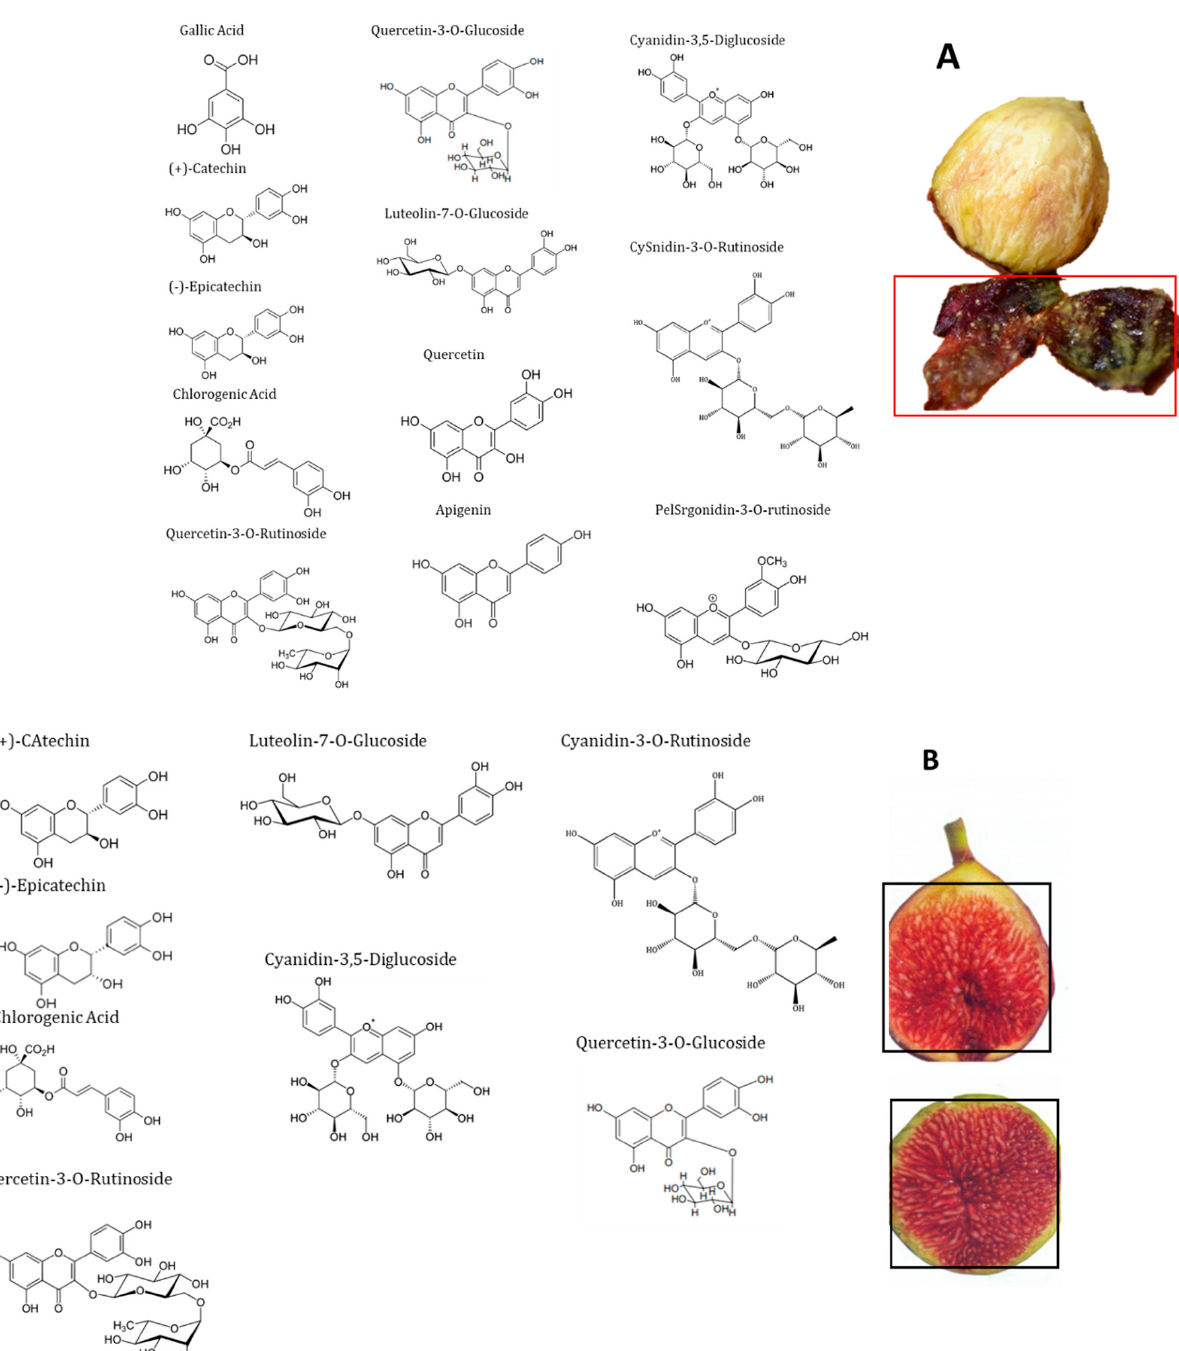
Figure 3. Chemical structures of the main phenolic compounds identified in the fig peels ( A ) and pulp ( B ).